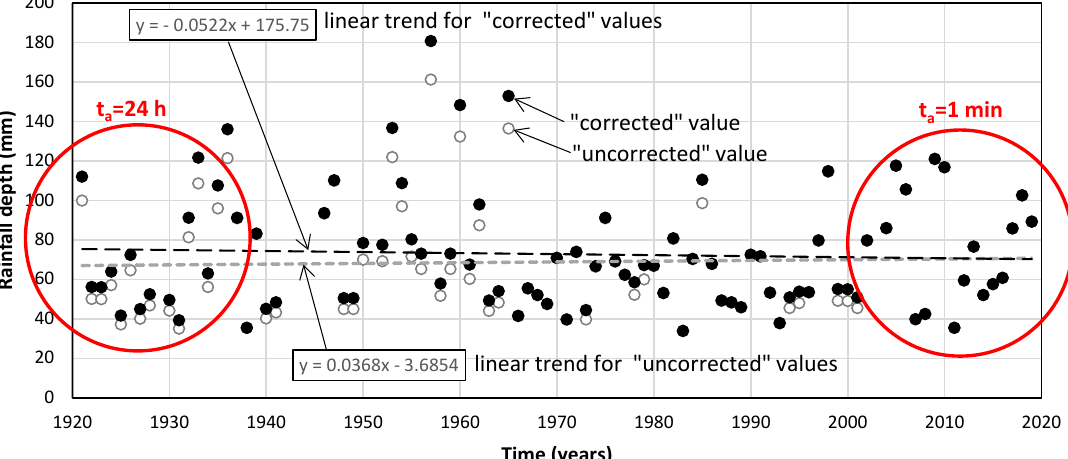
Figure 2. Time sequence of “uncorrected” and “corrected” annual maximum rainfall depths for duration 24 h, H d= 24 h , with the respective linear trends, for Terni station. The red circles highlight periods where the H d= 24 h values have been obtained from rainfall data with the indicated aggregation time, t a . During the period 1936–2001 H d= 24 h values have been obtained from rainfall data with variable t a . Available data within the period 1921–2019.